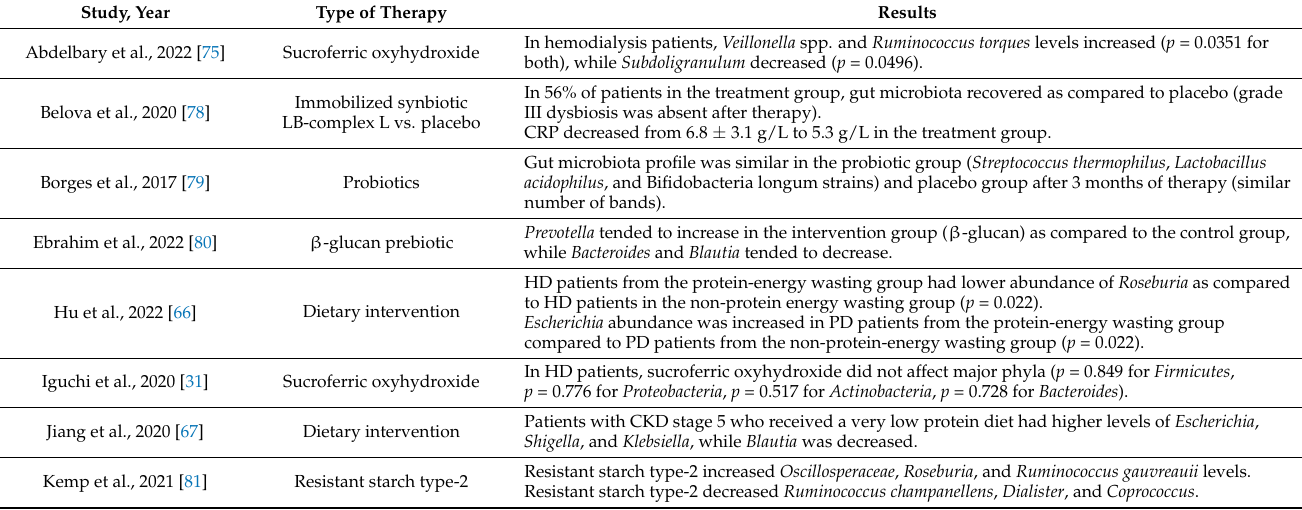
Table 3. Studies reporting gut microbiota modulation in CKD